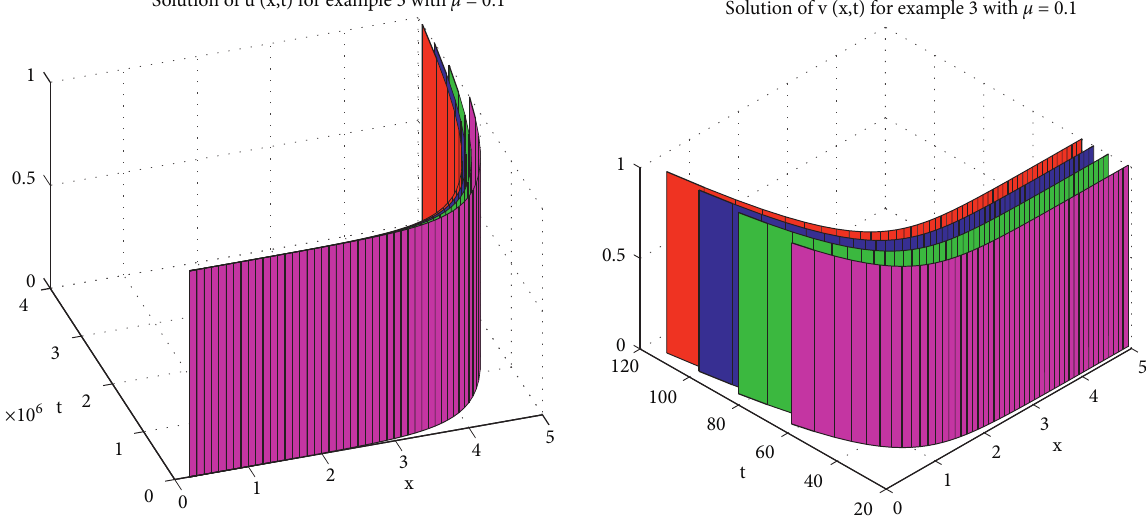
Figure 6: 3D graphical representation for u ( x,t ) and v ( x,t ) of equation